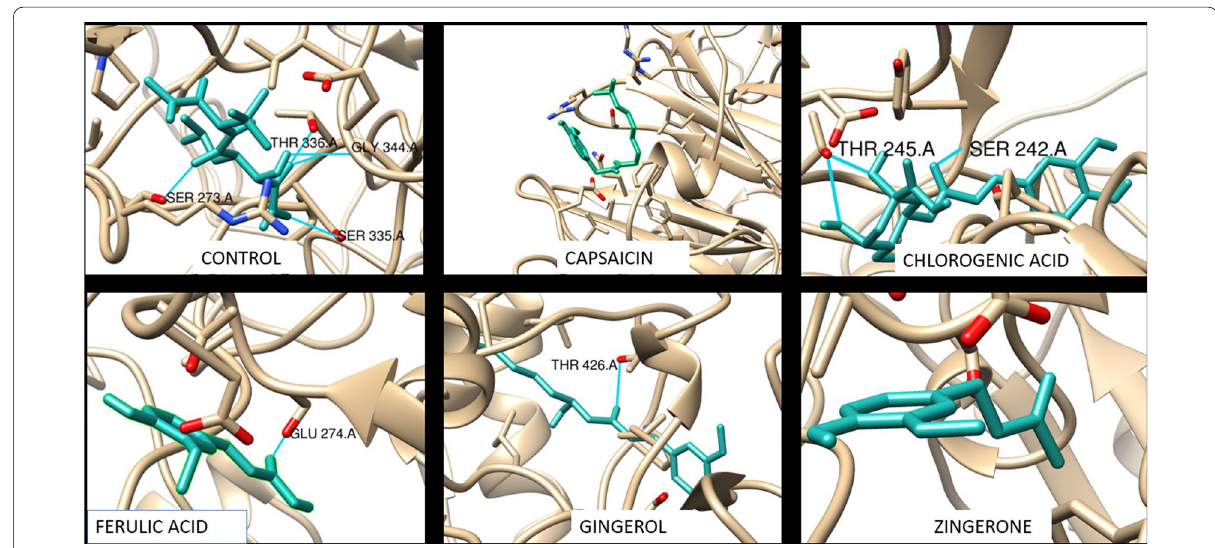
Fig. 2 Docked pictures of curcumin analogues and marimastat (control) against MMP-9 receptor. (Ligand represents the blue sticks, hydrogen bond interaction is represented in blue line, and receptor is represented in solid white ribbon form)